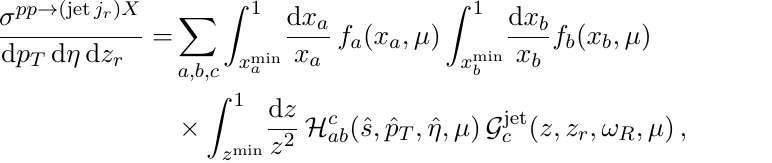
results for four di(cid:11)erent intervals of r=R